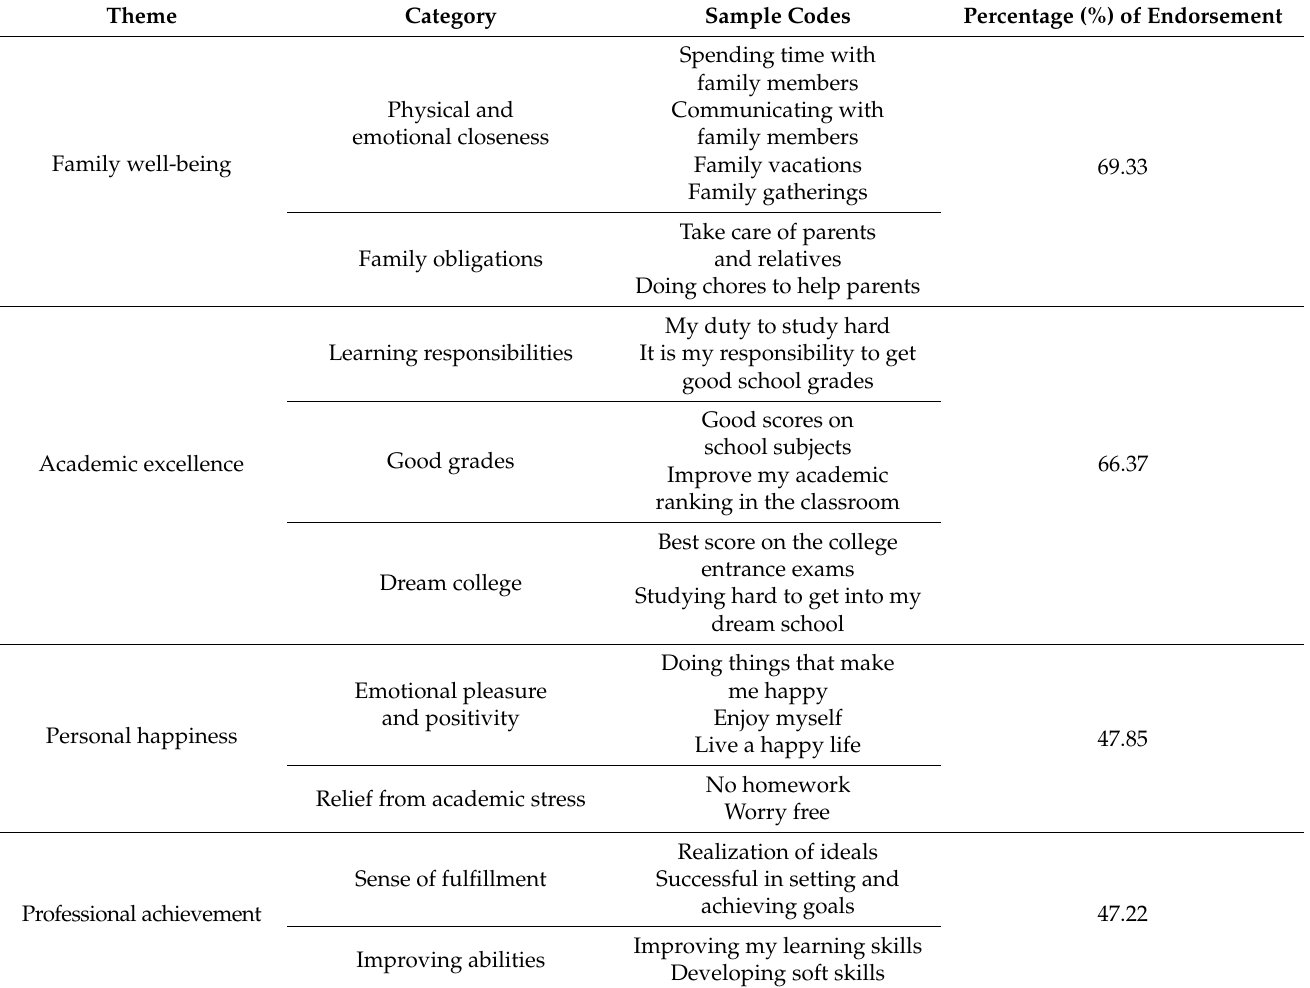
Table 1. Coding Manual and Percentage of